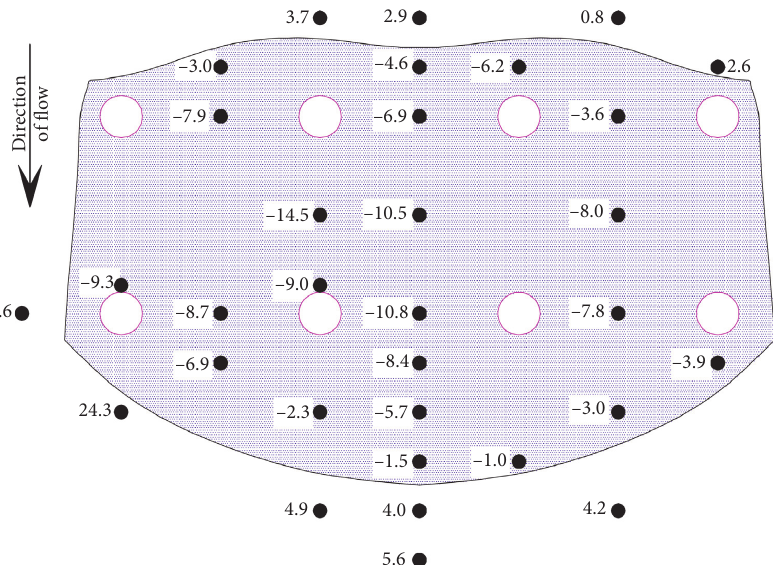
Figure 5: Schematic diagram of temperature field distribution.